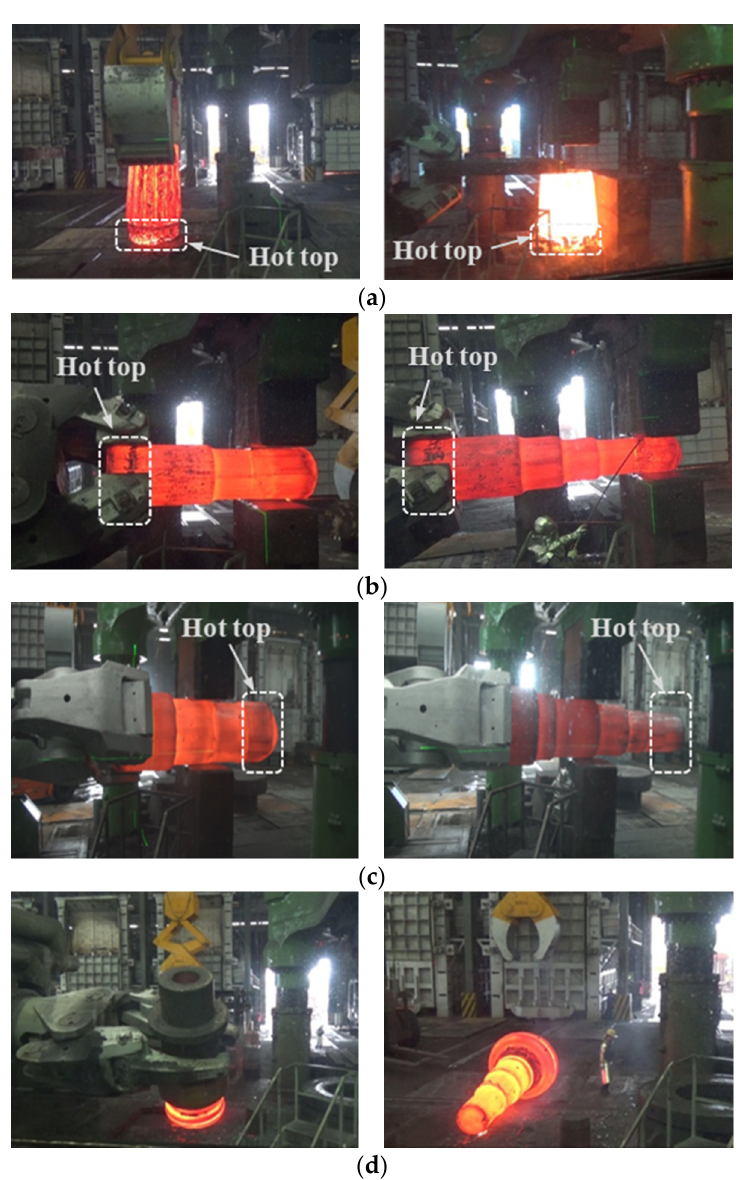
Figure 8. Shop floor main shaft forging: ( a ) upsetting; ( b ) cogging and necking for method 1; ( c ) cogging and necking for method 2; ( d ) semi-die forging.